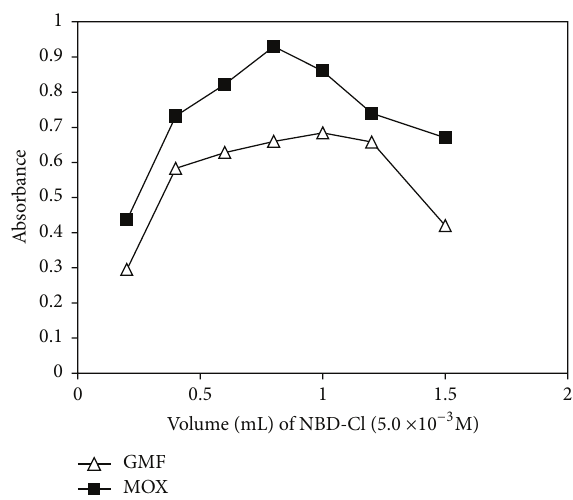
Figure 3: Effect of volume (mL) of NBD-Cl (5.0 × 10 −3 M) on the development of the reaction product at optimum temperature and time.